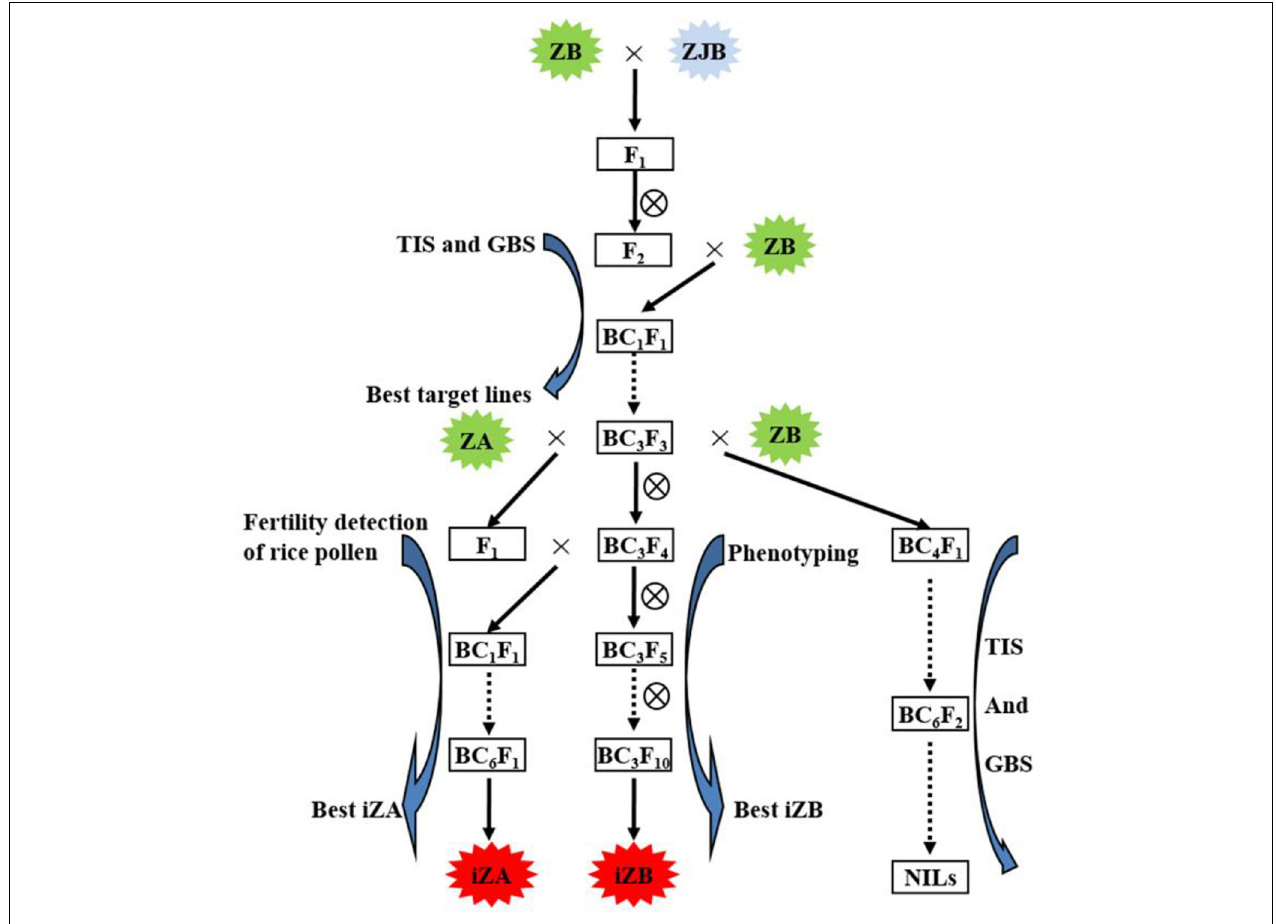
FIGURE 1 | Working routine of the construction of near-isogenic lines (NILs) and iZA breeding by molecular marker-assisted selection. ZB, Zhengshan 97B; ZJB, Zhengjia B; ZA, Zhengshan 97A; TIS, the target interval selection; GBS, the genetic background selection; iZA, improved ZA; iZB, improved ZB. ZB was the recipient parent, and ZJB was the donor parent of the target